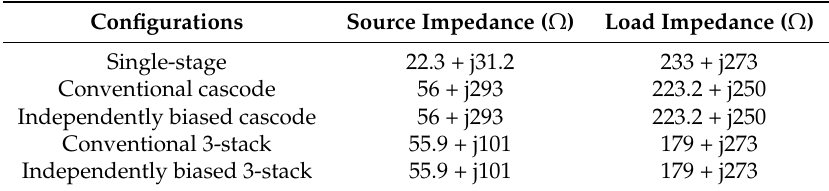
Table 2. Optimum source and load impedances of the compared configurations.